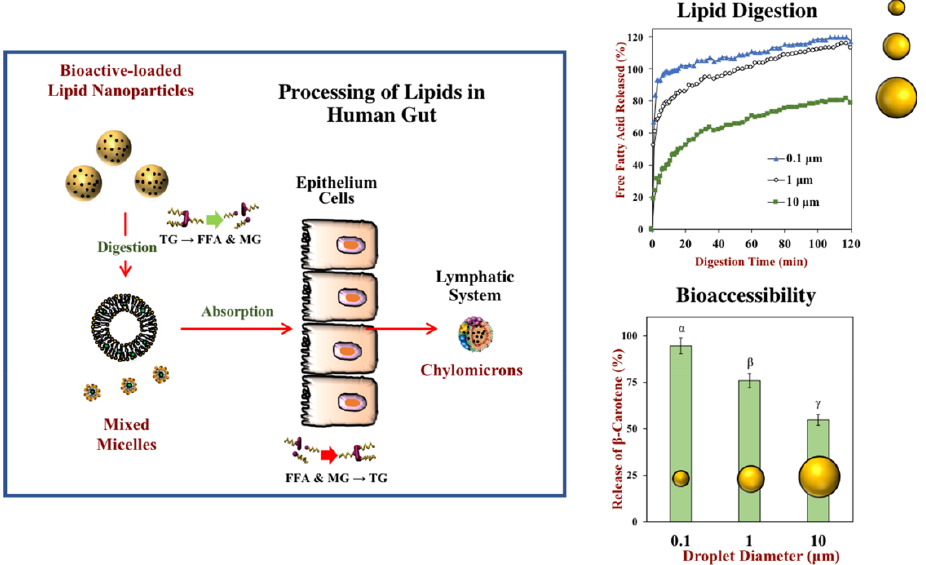
Figure 3. Bioavailability of hydrophobic bioactive substances can be increased by encapsulating them in nanoparticles. The triglycerides (TG) in the lipid nanoparticles are broken down into free fatty acids (FFA) and monoglycerides (MG), which are packed into mixed micelles with bioactive substances and transported to the epithelium cells. They are then reassembled into triglycerides, packed into chylomicrons, and transported into the bloodstream through the lymphatic system. Lipid digestion and nutraceutical bioaccessibility increase with decreasing droplet size. Reproduced with permission from ref. [78]. Copyright 2020 by the American Chemical Society. Table 1. Application of nanomicelles in delivering food nutrients and bioactives.